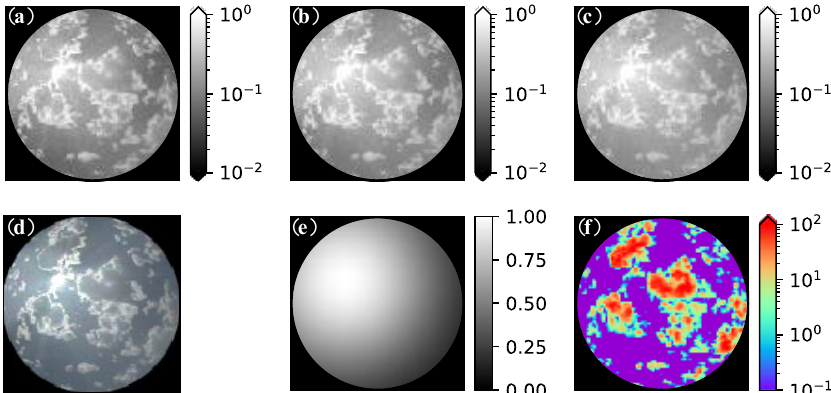
Figure 8. Example of the input and output of the CNN for the estimation of slant-column COT (SCOT) from the sky-camera images. Shown are the spectral radiances from the ( a ) red, ( b ) green, and ( c ) blue channels, normalized by dividing by 800 W m − 2 sr − 1 µ m − 1 , ( d ) a true-color image, ( e ) a solar position image, and ( f ) the SCOT along the line of sight corresponding to each pixel. The spectral responses of a commercial digital camera with a fish-eye lens are predetermined and assumed in the simulations. The input to the CNN is a four-channel image composed of ( a – c , e ), and the output is a single-channel image of ( f ). The solar zenith and azimuth angles are 26 ◦ and 184.2 ◦ , respectively. The centers of the images are oriented to the zenith, the field of view is within 45 ◦ from the center, and an equidistant projection is assumed.